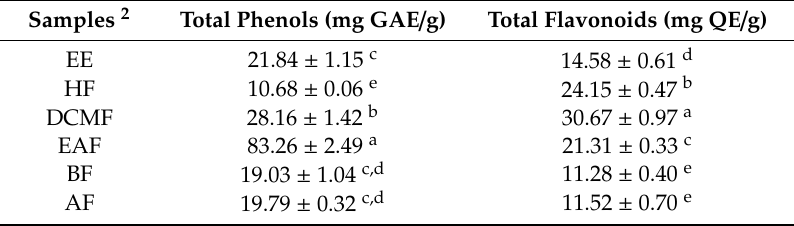
Table 1. Total phenolic and flavonoid contents of Rumex crispus L. root extracts and fractions 1 .